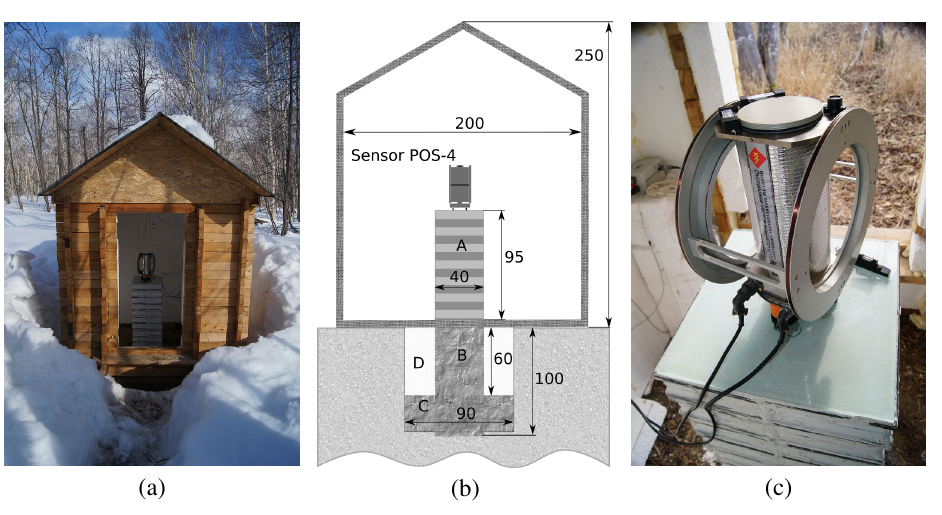
Figure 3. Location of the magnetometer POS-4 at the Observatory Paratunka: (a) the external appear- ance of the pavilion; (b) a design of the pavilion and the pillar (dimensions in cm); (c) a sensor on the pillar, the level for rough control of the pillar slopes is visible on the